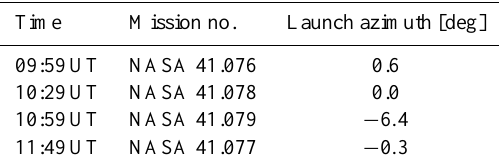
Table 1. Designations for turbopause payloads with launch times and azimuth (clockwise from